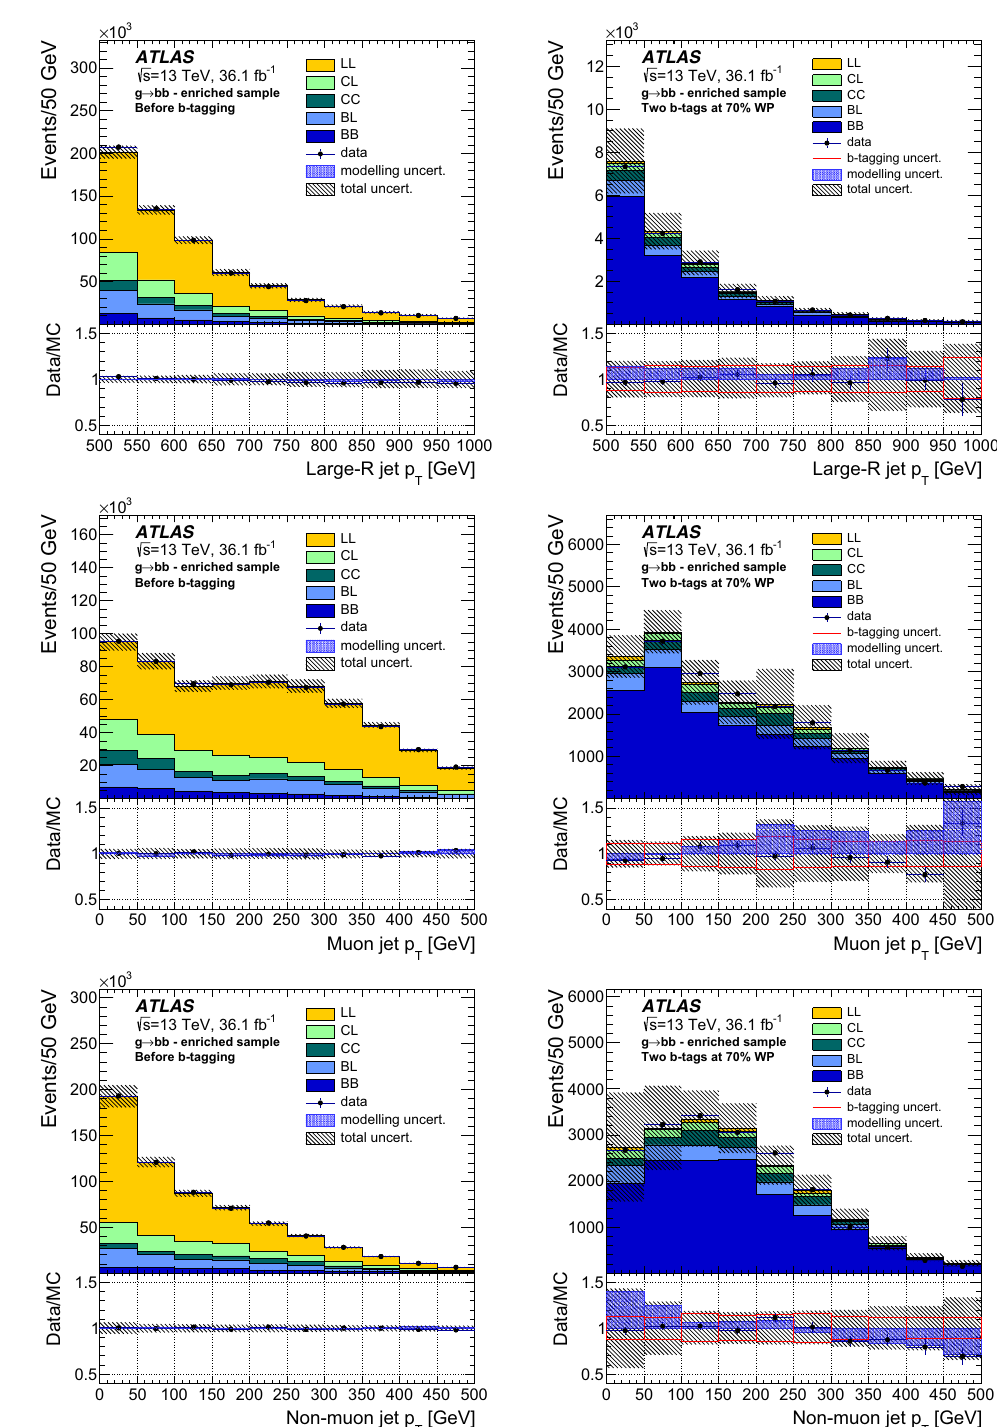
Fig. 15 Transverse momentum distributions of the large- R jet (top), j trk μ (middle) and j trk non- μ (bottom) before (left) and after (right) dou- ble b -tagging. The flavour-tagging correction factors and the flavour-fit corrections have been applied. The two largest systematic uncertainties,